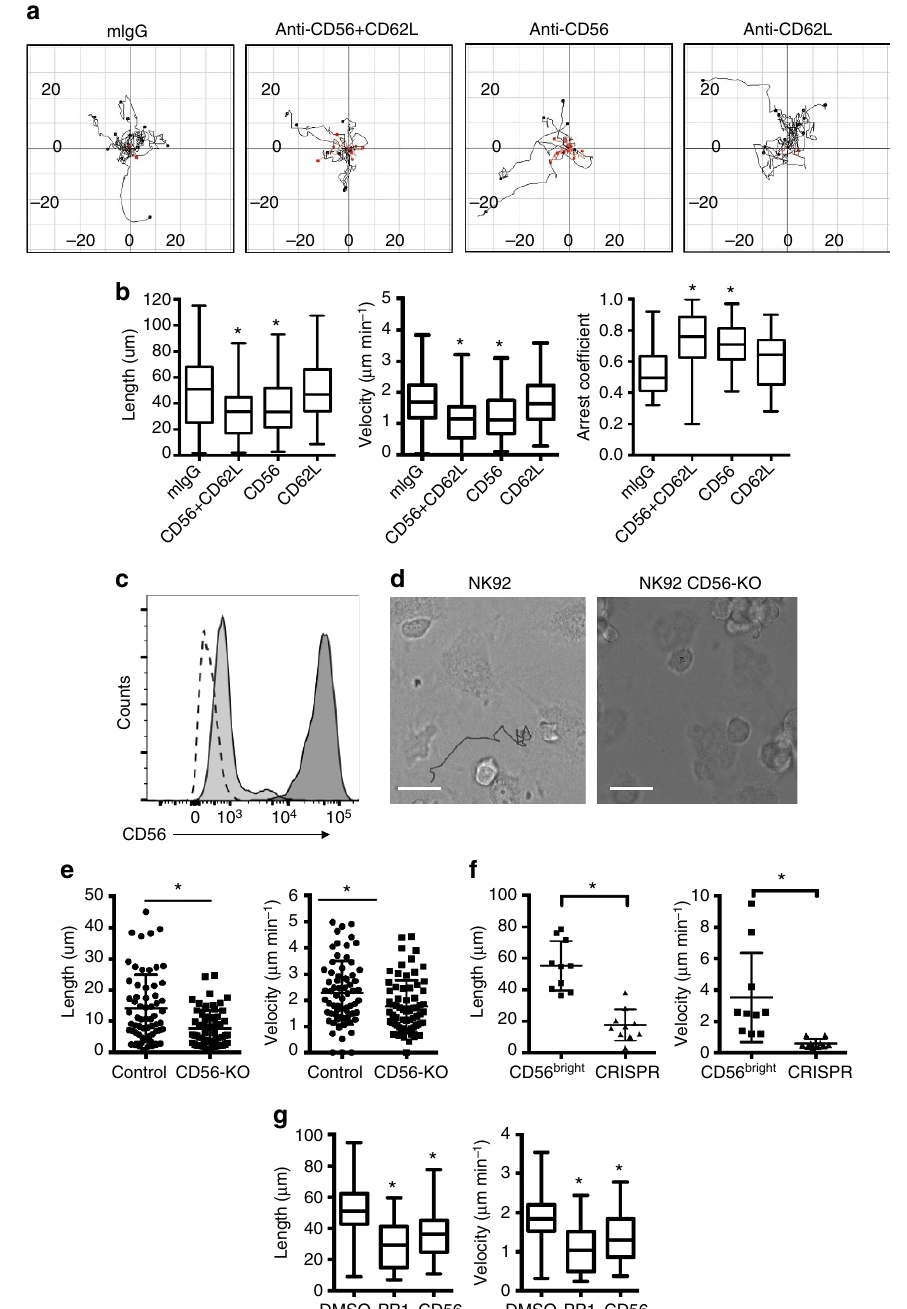
Figure 4 | NK cell motility is dependent upon CD56 and Src kinase signalling. CD56 bright NK cells were purified and pre-incubated in the presence of anti-CD56 and/or CD62L blocking antibody or mouse IgG as a negative control then incubated on EL08.1D2 stromal cells for 4h. Cells were then imaged for 30min (2 frames per minute). ( a ) Cells were tracked with Manual Tracking (FIJI) and tracks with velocity of o 1 m mmin (cid:2) 1 are shown in red. n ¼ 10 from one representative experiment. ( b ) Length, velocity and arrest coefficient were measured from manually tracked cells. n ¼ 70 from three independent experiments. Data are represented as mean ± s.d. P o 0.0001 by ordinary one-way ANOVA. * P o 0.05 by post hoc Tukey’s comparison with mIgG condition. ( c ) Expression of CD56 on NK92 CD56-KO cell lines was measured by flow cytometry. Isotype control is shown as a dashed line, wild-type NK92 are represented by the dark histogram and CD56-KO is the light histogram. ( d ) NK92 (wild type, left, or CD56-KO, right) were visualized by live-cell confocal microscopy for 60min on EL08.1D2 stromal cells and tracked as in Fig. 1. Representative cell from each condition is shown with its track from 0 to 60min overlaid. See also Supplementary Movies 5 and 6. Scale bar, 10 m m. ( e ) Track displacement and velocity were measured for one representative experiment of three independent repeats described in ( d ) n ¼ 70. Data are represented as mean ± s.d. * P o 0.05 by Student’s unpaired t -test. ( f ) Purified CD56-KO cells derived from CD56 bright ex vivo NK cells were visualized by live-cell microscopy for 30min on EL08.1D2 stromal cells and track length and velocity were measured. n ¼ 10 from one representative experiment of three. Data are represented as mean ± s.d. * P o 0.05 by Student’s unpaired t -test. ( g ) CD56 bright NK cells were pre-incubated with PP1 Src kinase inhibitor, anti-CD56 blocking antibody or DMSO as a vehicle control then imaged and tracked. n ¼ 52 from three independent experiments. Data are represented as mean ± s.d. P o 0.0001 by ordinary one-way ANOVA. * P o 0.05 by post hoc Tukey’s comparison with DMSO condition. NATURE COMMUNICATIONS|7:12171|DOI: